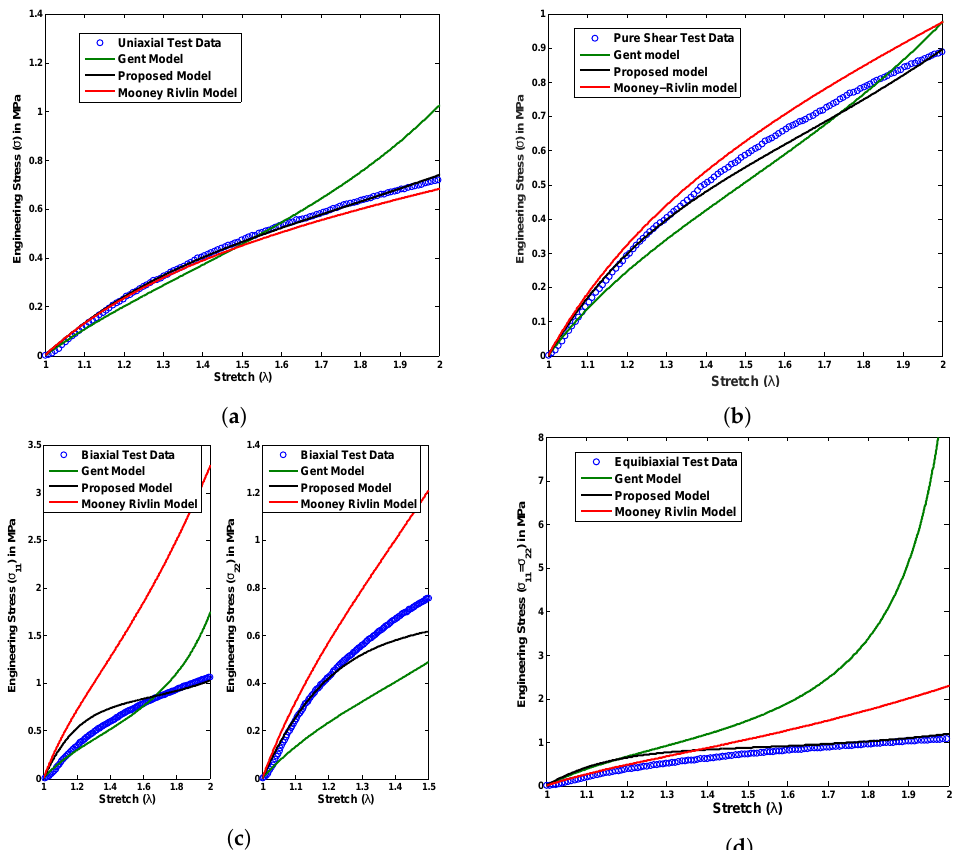
Figure 5. Experimental validation of the proposed model with Latex test data compared to the existing material models under all possible deformation modes, ( a ) uniaxial, ( b ) pure shear, ( c ) biaxial, and ( d ) equibiaxial for a single set of material